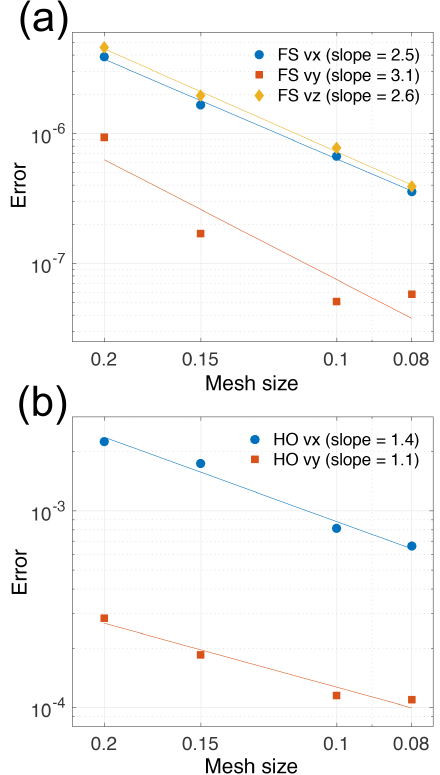
Figure 2. Convergence rates of the simulated (a) full-Stokes (FS) and (b) higher-order (HO) velocity fields (v x ,v y ,v z ) to the analyt- ical solutions in Eqs. (13)–(17) for increasing mesh